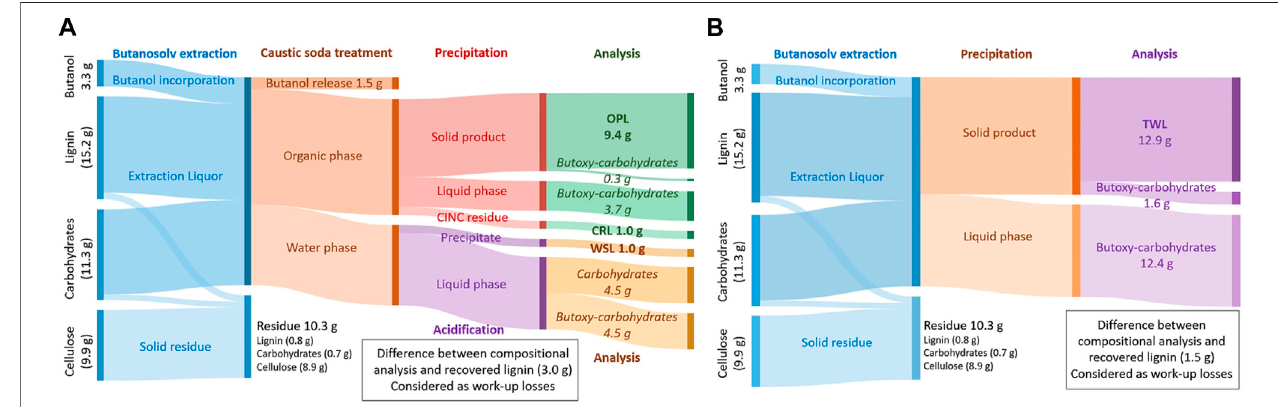
FIGURE 5 | Sankey-diagrams of the lignin and polysaccharide fractions of a fl ow-through butanosolv lignin extraction of walnut shells with a combined in-line causticsodatreatmentinaCINCdeviceandsubsequentprecipitationstep (A) andthetraditionalwork-upprocedureconsistingofasingleprecipitation step (B) .Values between brackets are determined by compositional determination of the starting material and residue. OPL (cid:1) Organic-phase lignin, CRL (cid:1) CINC residual lignin, WSL (cid:1) Water-soluble lignin, and TWL (cid:1) Traditional work-up lignin.